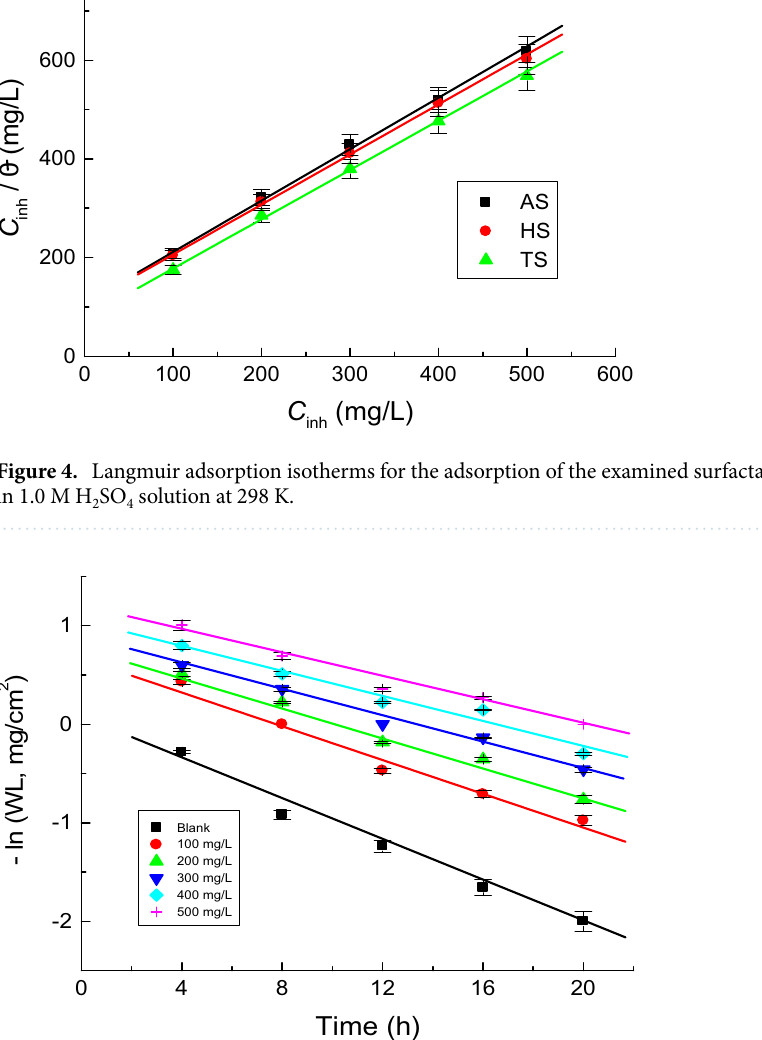
Figure 5. First-order rate constant plots for the copper corrosion in 1.0 M H 2 SO 4 solution and in the presence of the surfactant HS at 298 K.